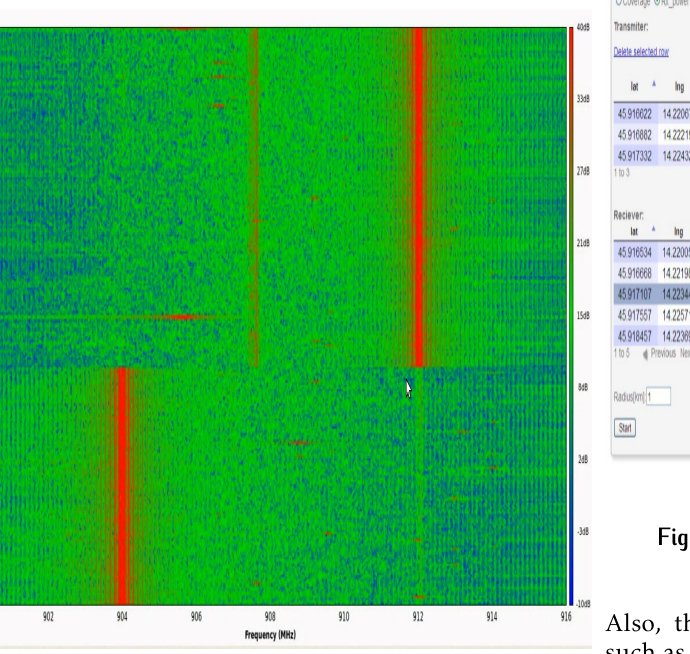
figure 10. The transmitters radio coverage calculation and visualisation is expressed through the figure 10.